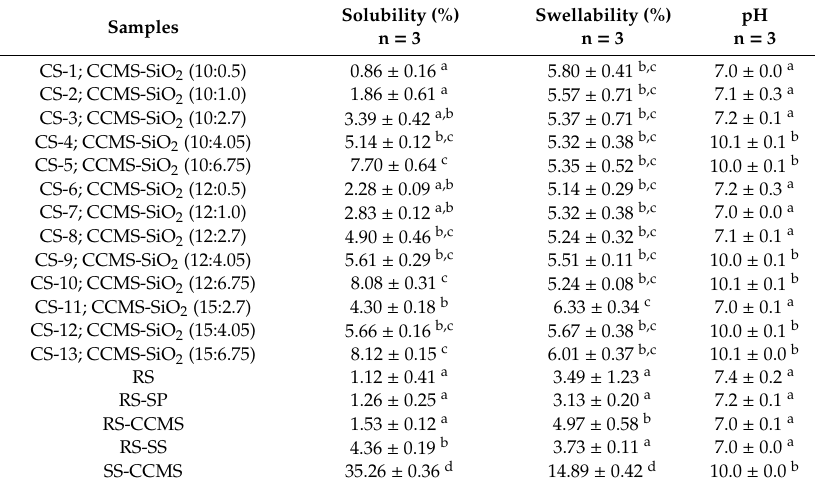
Table 1. Co-processed conditions, solubility, swellability, and pH of native rice starch (RS), spray-dried rice starch (RS-SP), and co-processed starches.